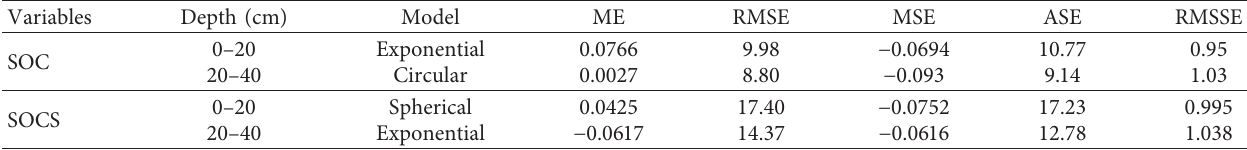
Table 6: Cross-validation indices of the ordinary kriging (OK) interpolation method for SOC and SOCS. Variables Depth (cm) Model ME RMSE MSE ASE RMSSE